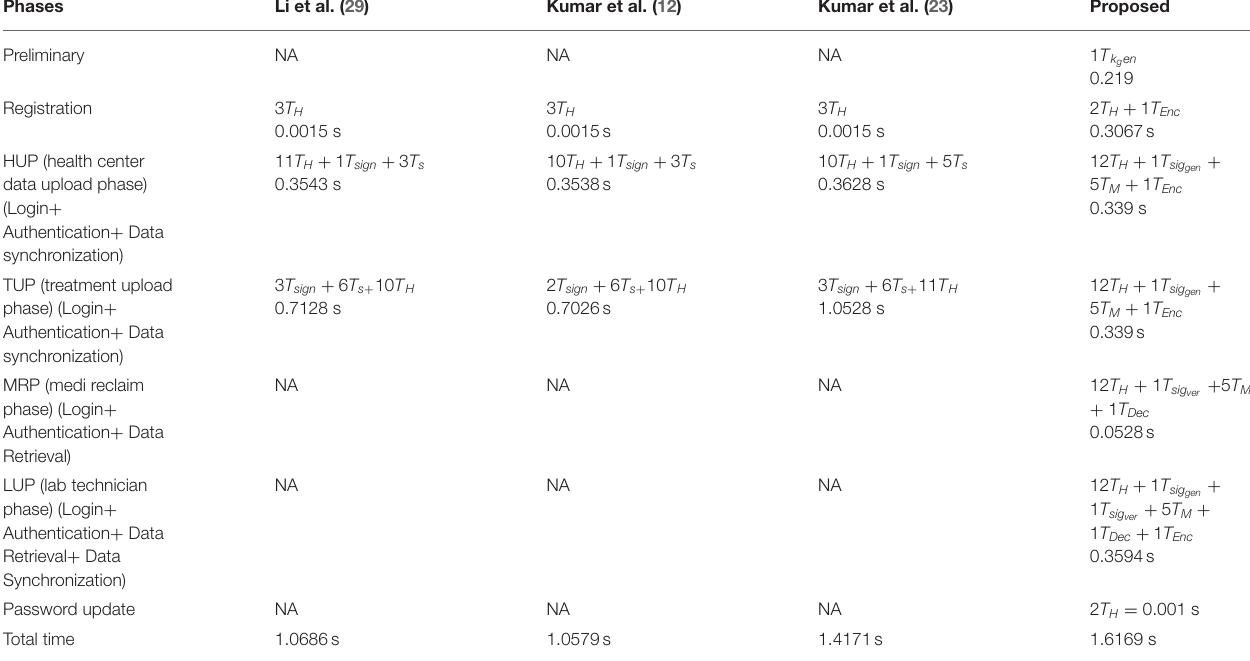
TABLE 3 | Computation cost of SCB-HC protocol with relevant protocols.